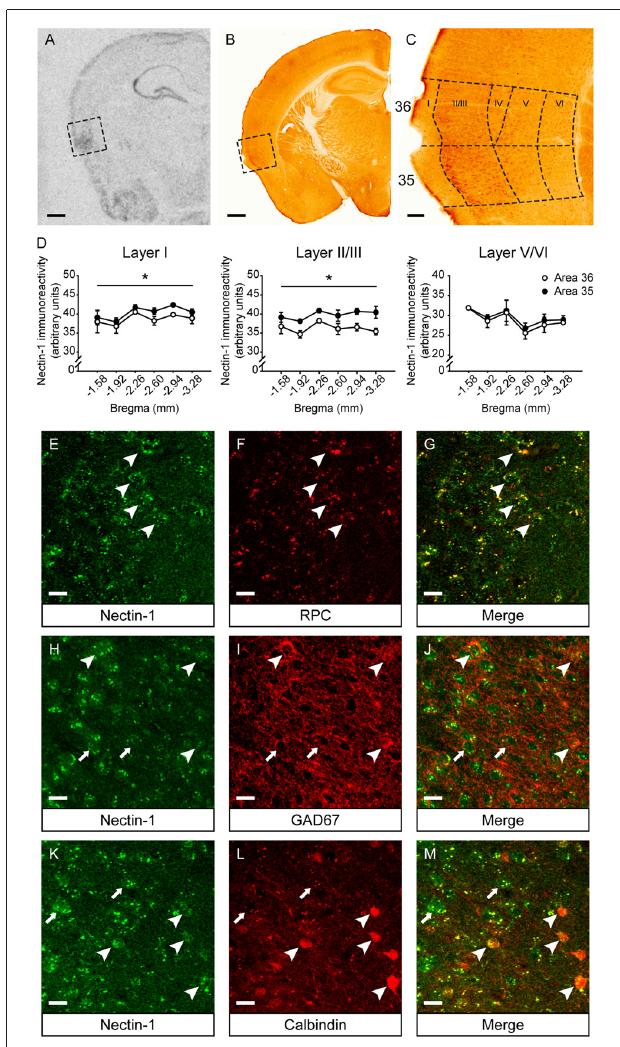
FIGURE 2 | Nectin-1 mRNA and protein expression patterns in the adult mouse perirhinal cortex. (A) An in situ hybridization image showing nectin-1 mRNA expression in the perirhinal cortex (the boxed region) and adjacent brain regions. Scale bar = 500 µ m. (B) A representative image showing nectin-1 immunostaining in the perirhinal cortex (the boxed region) and adjacent brain regions. Scale bar = 500 µ m. (C) The magnified image of the insert in (B) showing nectin-1-positive cells in layers II–VI of areas 36 and 35. Scale bar = 50 µ m. (D) Analysis of nectin-1 immunoreactivity in layers I–VI of perirhinal areas 36 and 35. ∗ p < 0.05, main effect. n = 3 mice. (E–G) Nectin-1 colocalized with rat pyramidal cell (RPC), a marker for excitatory pyramidal neurons. Arrowheads indicate representative area 35 neurons co-immunostained with nectin-1 and RPC. (H–J) Nectin-1 partially colocalized with glutamic acid decarboxylase 67 (GAD67), a marker for inhibitory interneurons. Arrowheads indicate area 35 neurons that co-express nectin-1 and GAD67. Arrows indicate representative nectin-1-immunoreactive neurons surrounded by GAD67-positive inhibitory boutons. (K–M) Nectin-1 partially colocalized with calbindin, a marker for a subtype of pyramidal neurons and interneurons. Arrowheads indicate area 35 neurons co-immunostained with nectin-1 and calbindin. Arrows indicate representative nectin-1-positive neurons without calbindin expression. Scale bars for (E–M) are 20 µ m.